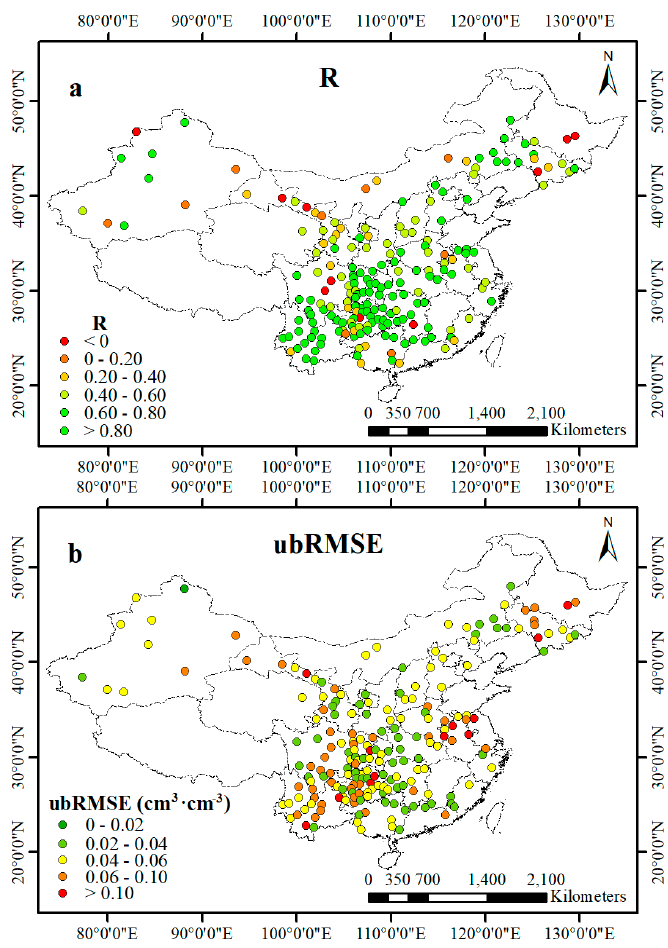
Figure 4. Spatial distribution of the ( a ) Pearson correlation coefficient (R), ( b ) unbiased root mean square error (ubRMSE) between 7-day averaged SMAP and in situ SM at 204 stations with both SM data and climate data in China (1 April 2016–30 September 2016).